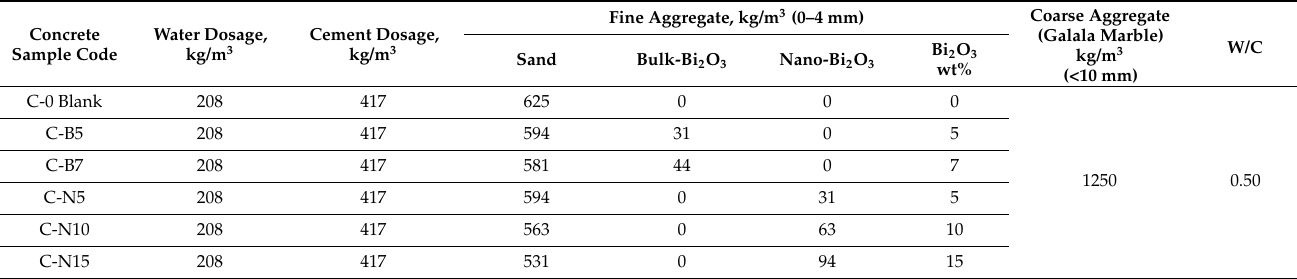
Table 1. The concrete sample mixes